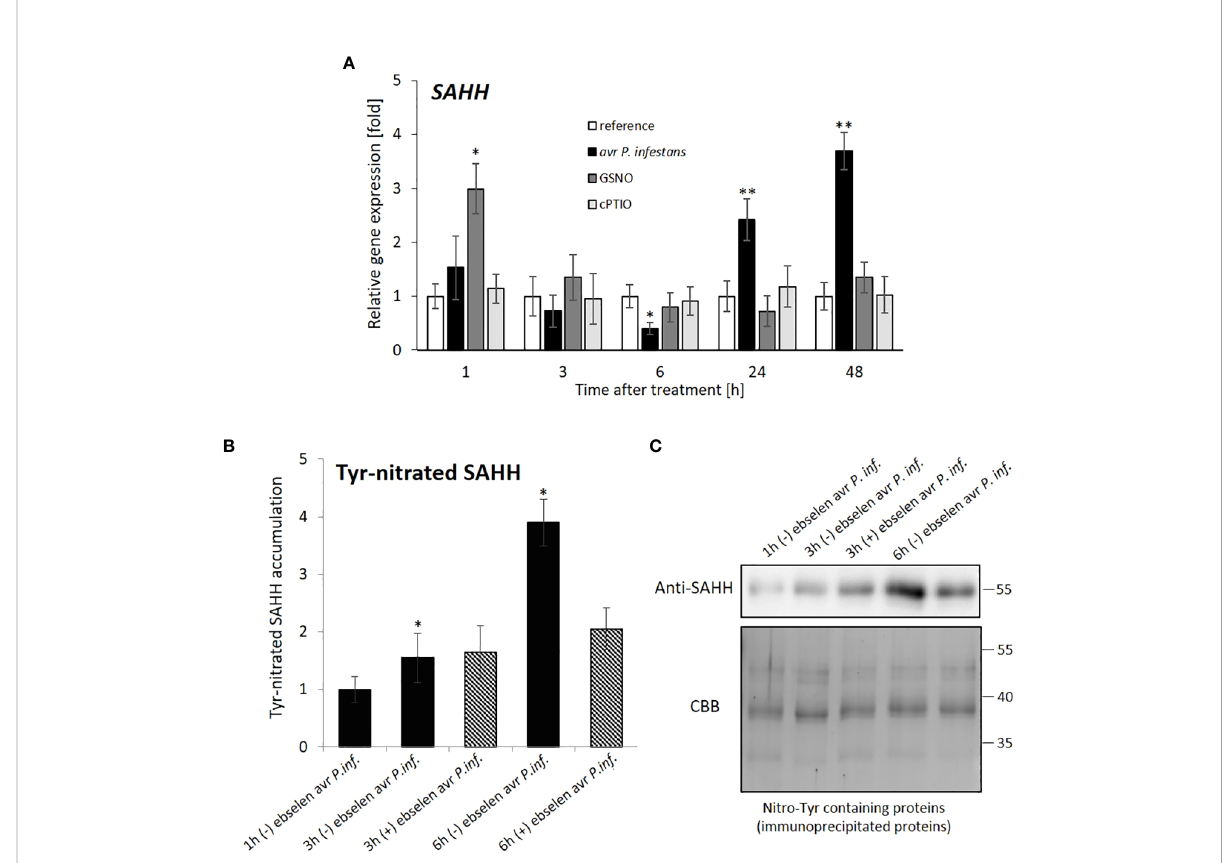
FIGURE 4 SAHH hydrolase expression pro fi le (A) and Tyr-nitration of SAHH in potato leaves (B, C) . RT-qPCR gene expression of SAHH was analyzed in potato leaves (at 1-48 h) after treatment with GSNO, cPTIO, water, or avr P . infestans inoculation, respectively. There were no signi fi cant changes in the absolute values of the analyzed SAHH transcript levels after the leaves spraying with water. For SAHH tyrosine nitration, potato leaves were inoculated with avr P . infestans in the presence (+) or absence (-) of ebselen (nitrating agent scavenger). A representative SDS-PAGE and Western blot of immunoprecipitated nitroTyr-containing proteins probed with a polyclonal antibody against S-adenosylhomocysteine hydrolase (SAHH) diluted at 1:2000. Protein extracts of S. tuberosum leaves were immunoprecipitated with an antibody against nitroTyr. The resulting immunoprecipitated proteins (0.2 µg per lane) were separated by one-dimensional SDS-PAGE in duplicate, and either Coomassie Brilliant Blue (CBB) stained or electrotransferred onto a PVDF membrane and probed with antibodies against SAHH. Asterisks indicate values that differ signi fi cantly from water-treated (reference) potato leaves at a <0.05 ( ∗ ) and a <0.01 ( ∗∗